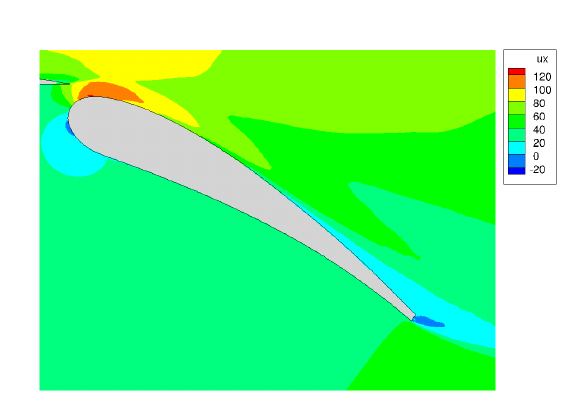
Figure 9. Time-averaged distribution of velocity component u x by the wall-modelled Navier–Stokes simulation around the flap when θ = 5.5 ◦ .